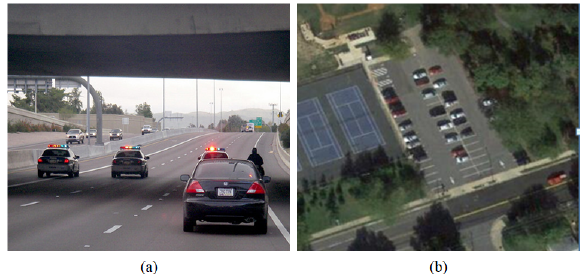
Figure 1. Comparison between the scales of the objects in natural images given by COCO dataset ( a ) and the scale of the objects in VHR aerial images given by NWPU VHR-10 dataset ( b ). It can be seen that the vehicles in natural images occupy a larger area compared with the vehicles in VHR aerial